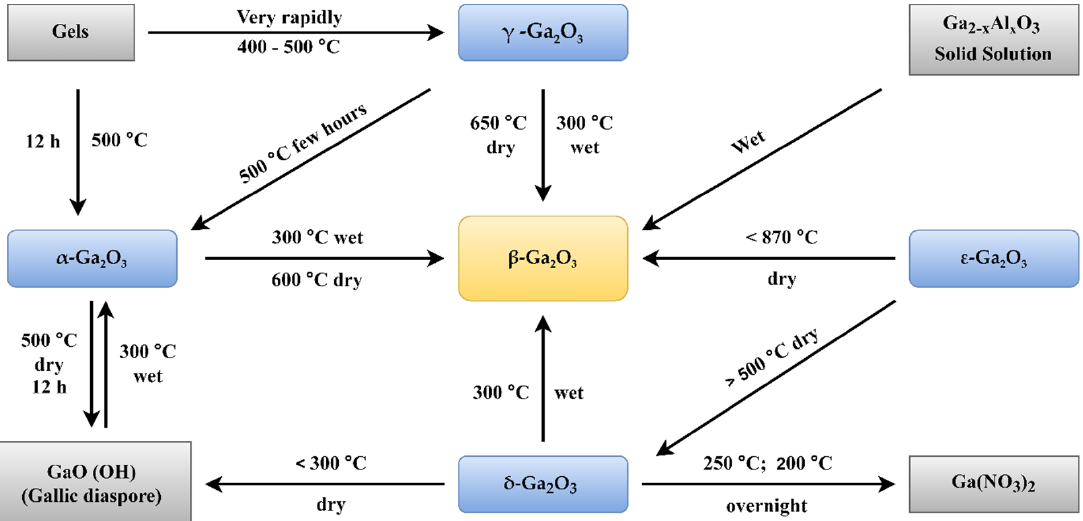
Figure 2. Transformation of Gallium oxide polymorphs to β -Ga 2 O 3 [52]. “Reprinted with permission from Ref. [52]. Copyright (1952), ACS Publications”. Table 1. Polymorphs of Gallium Oxide.